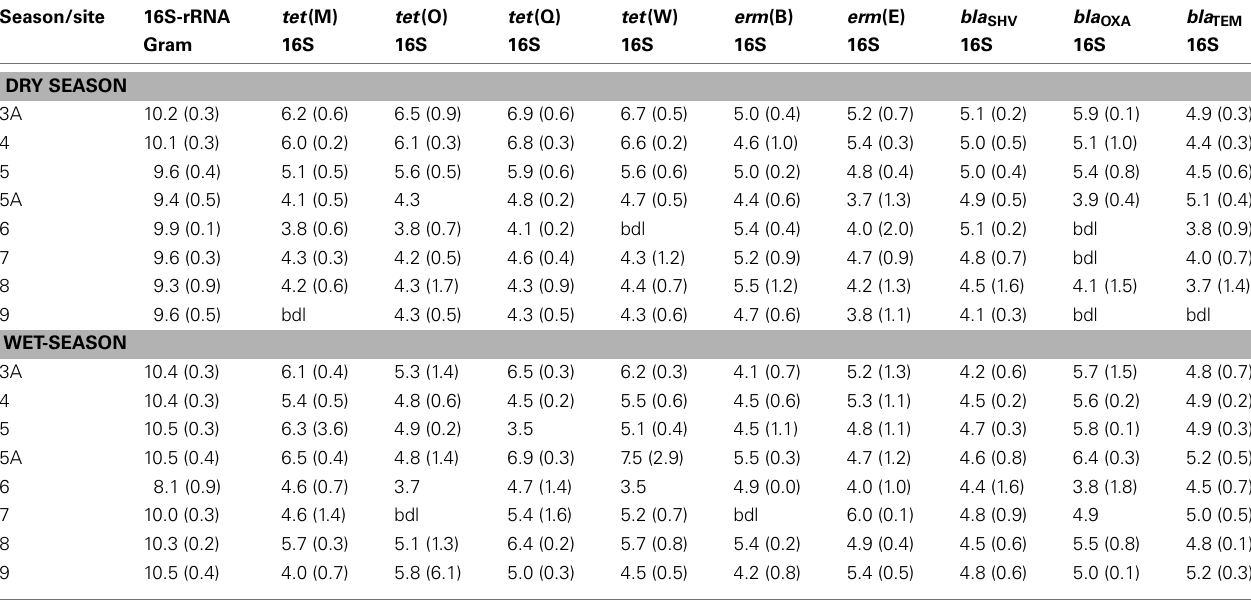
TableA3 |Total 16S-rNA and resistance gene abundances (per gram-sediment) in theAlmendares River.